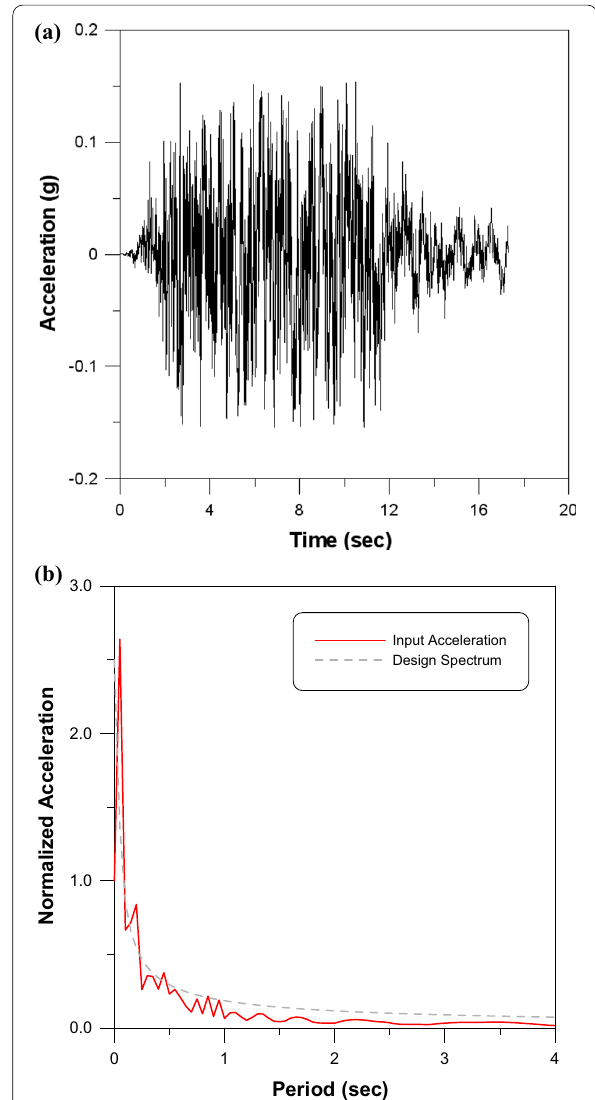
Fig. 8 Input acceleration: a artificial acceleration and b response